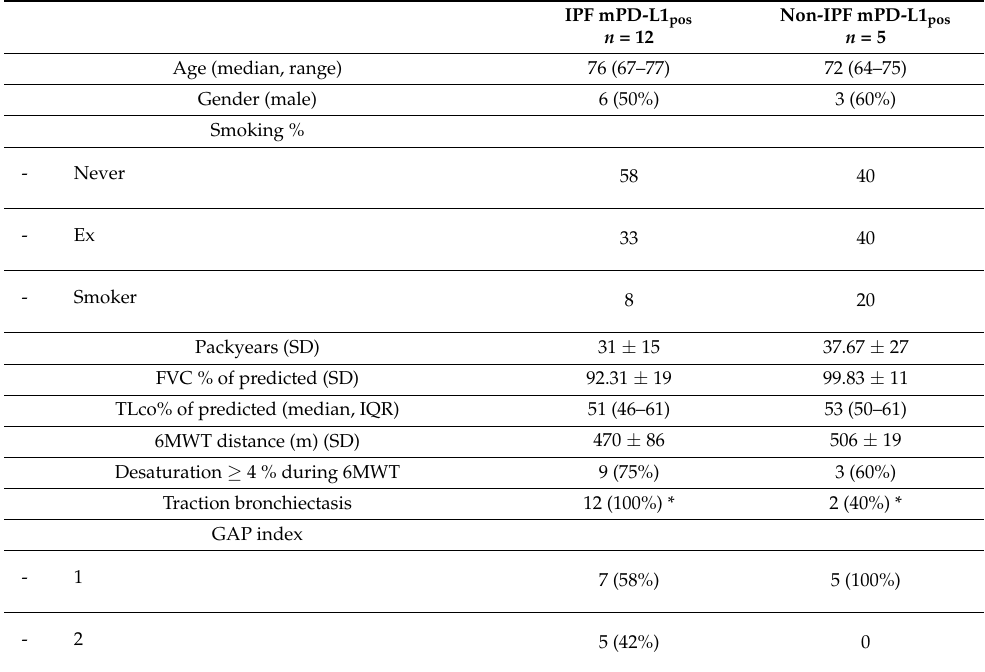
Table 2. Demographic characteristics of patients with PD-L1-positive membrane staining with IPF and without IPF.